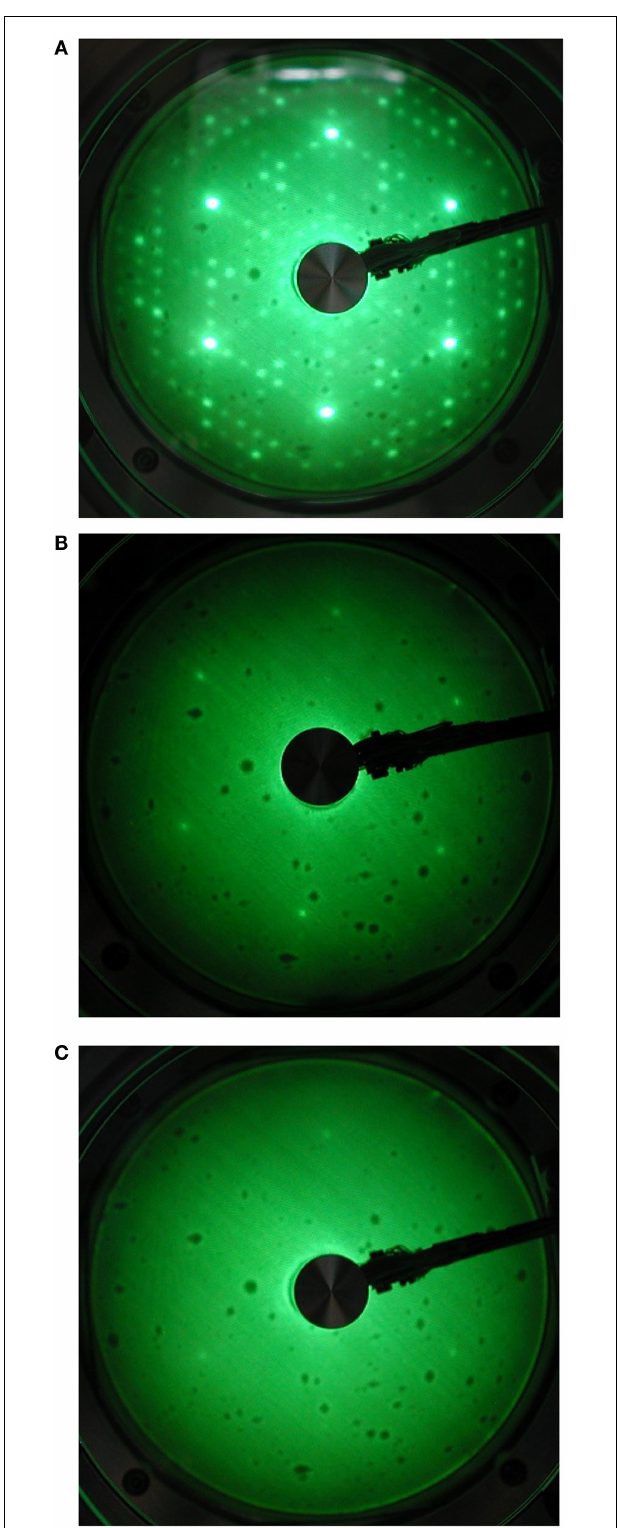
FIGURE 4 | LEED patterns (at 50eV) of (A) a clean Si(111) 7 (cid:2) 7 surface, (B) a submonolayer film of C 60 at KE of 18eV, and (C) a submonolayer film of C 60 at KE of 30eV